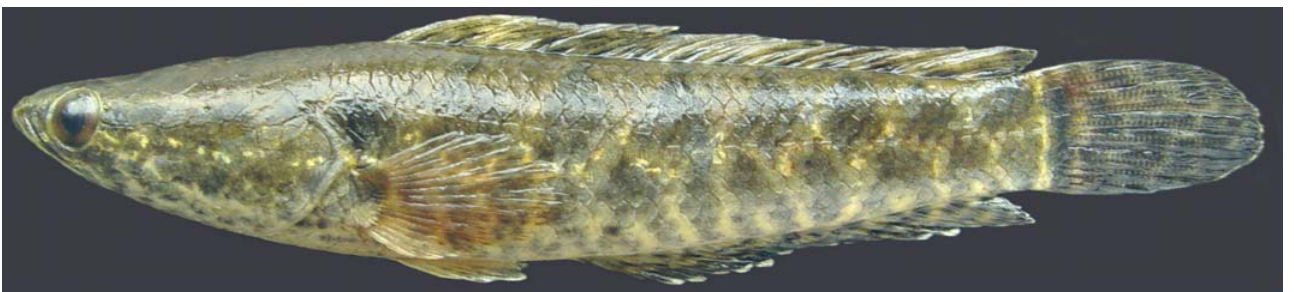
Image 8. Side view of Channa punctatus (GUMF